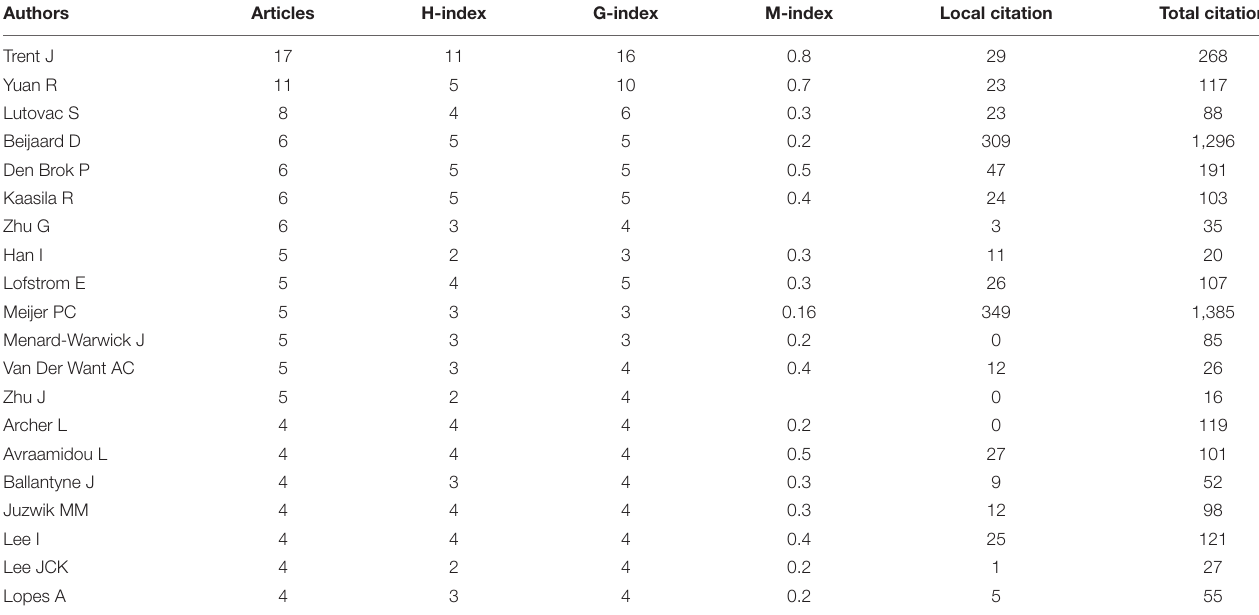
TABLE 4 | Most relevant